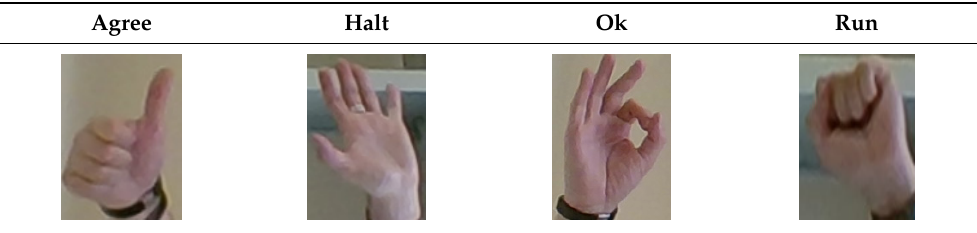
Table 2. Hand position for each gesture.